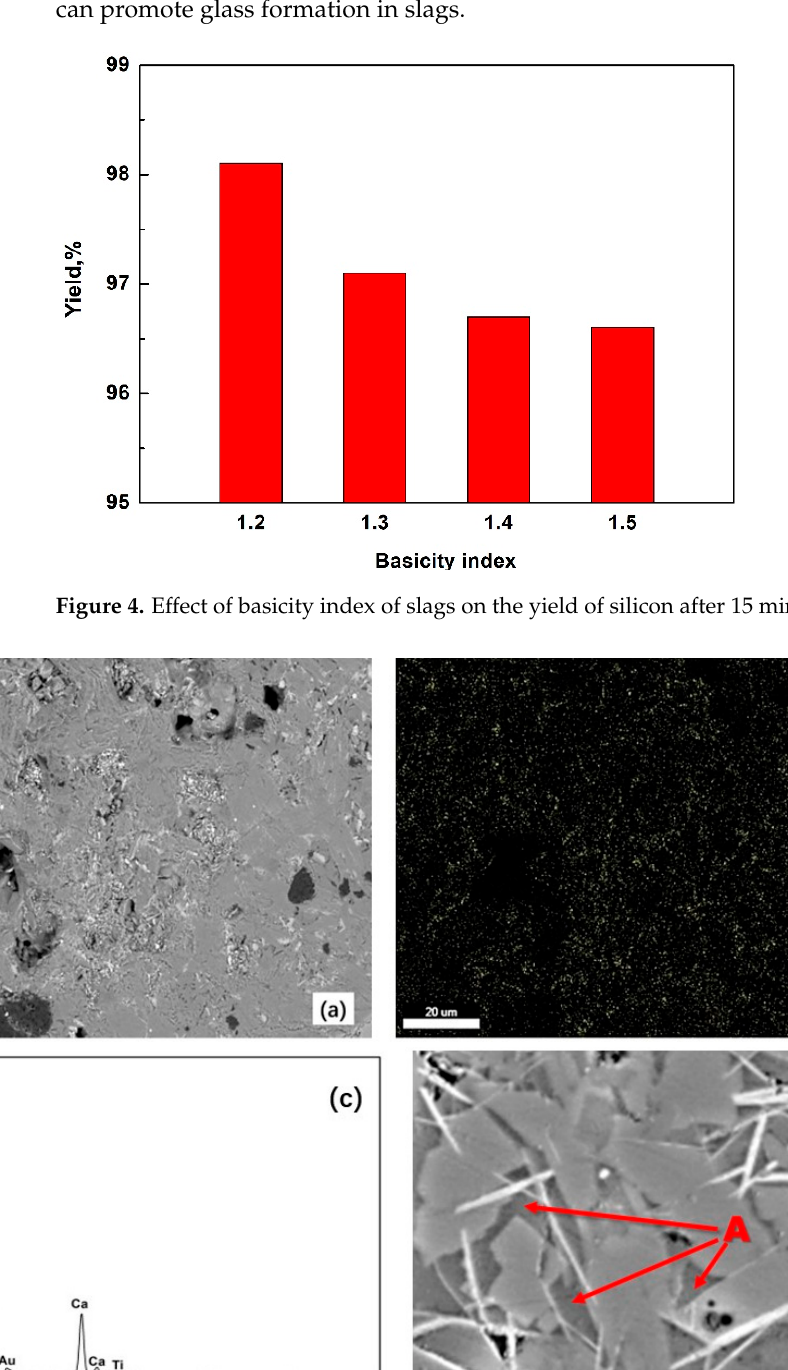
Figure 4. Effect of basicity index of slags on the yield of silicon after 15 min of refining.